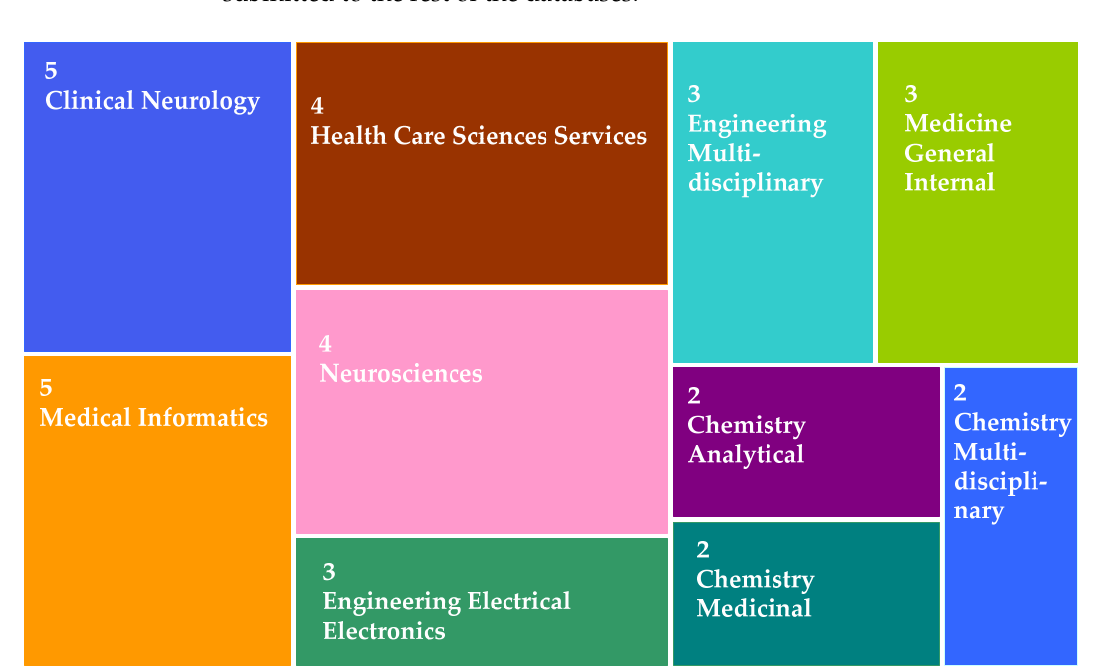
Figure 3. Distribution of journals from Web of Science from Core Collection.